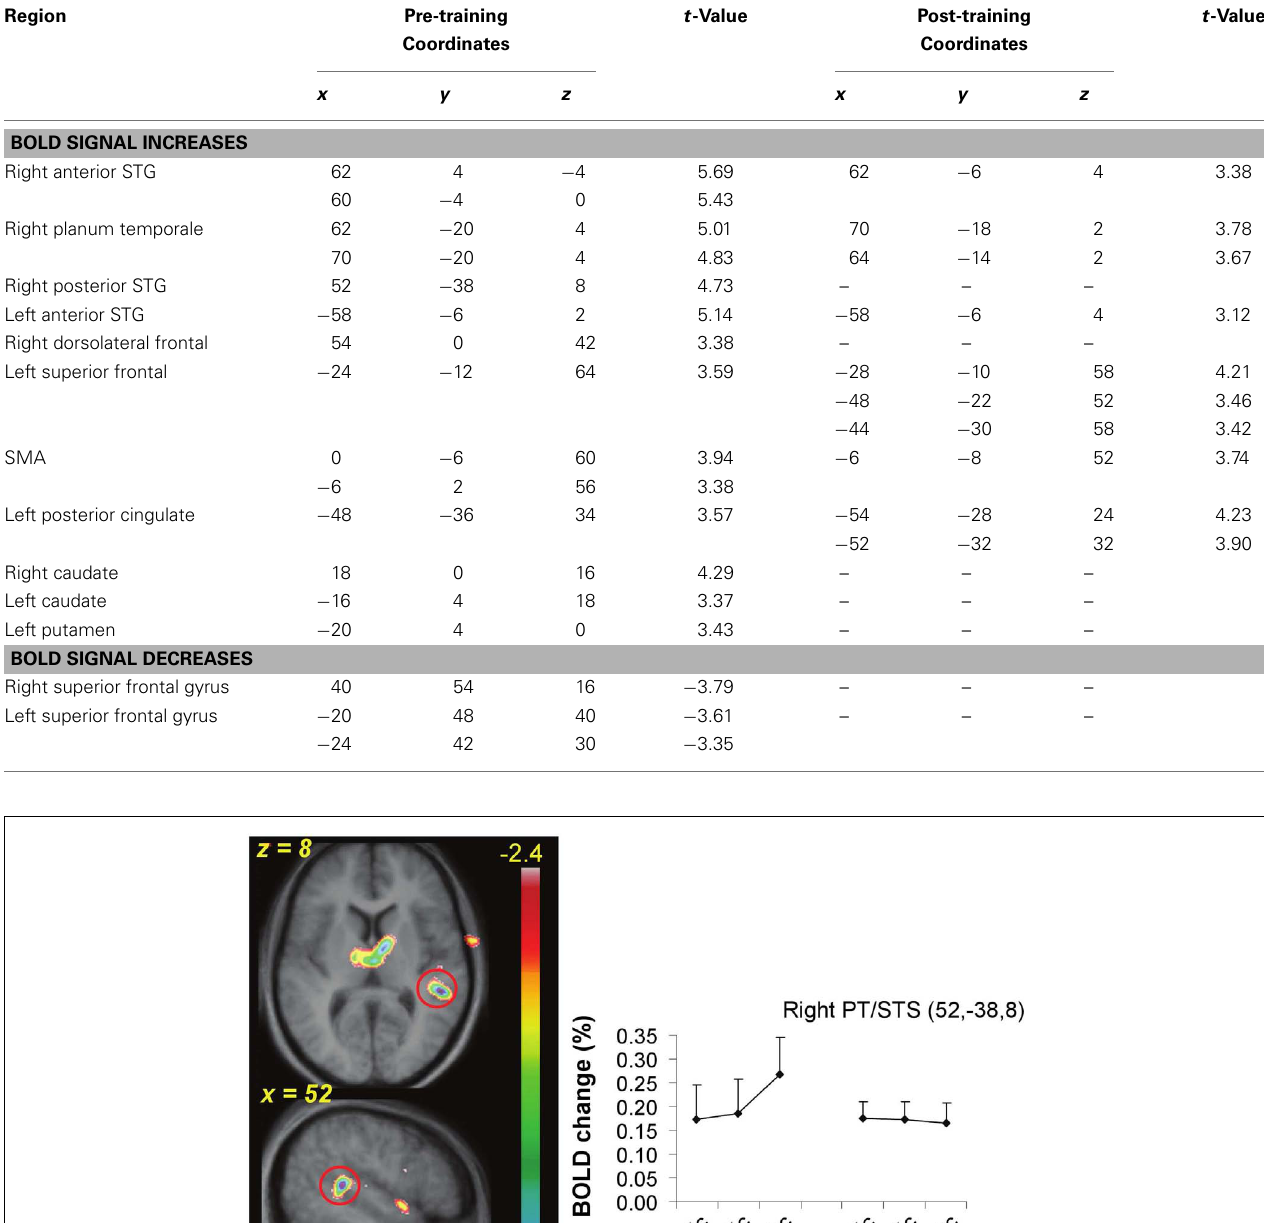
FIGURE 6 | Functional MRI data from the active task showing the site of maximal interaction between change in BOLD as a function of pitch interval size and effect of training. A region near planum